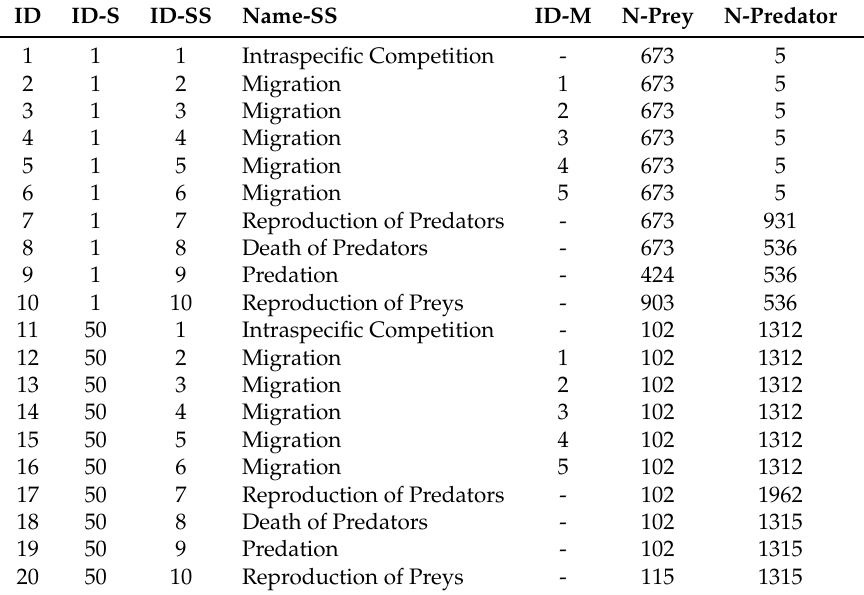
Table 7. Simulation carried out without using agents—Case